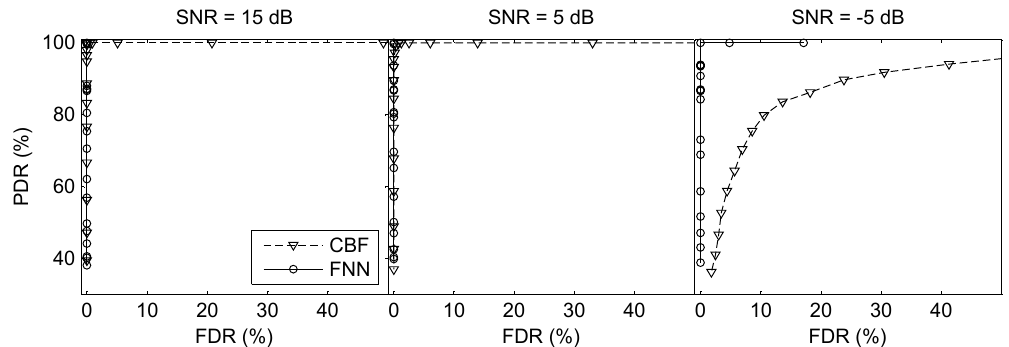
Figure 10. ROC curves of direction finding on HCA under different SNRs in the three-source scenarios. Table 2. The performance comparison under different SNRs in the two-source and three-source scenarios using the simulated data on